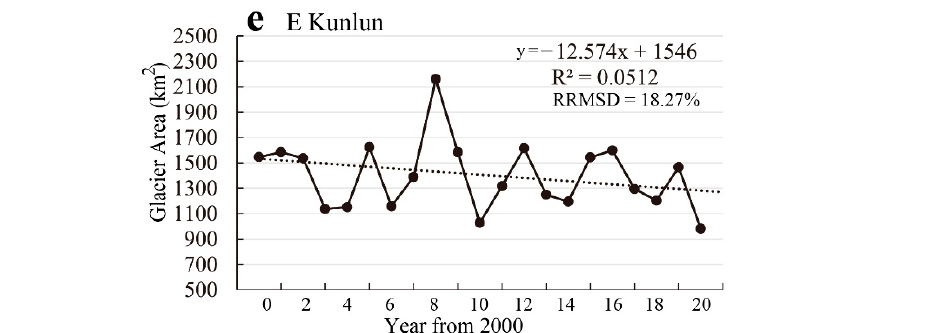
Figure 5. Evolution of annual glacier area in the subregions of the Tarim Basin in 2000–2020: ( a ) E Tien Shan; ( b ) W Tien Shan; ( c ) Pamir; ( d ) W Kunlun; ( e ) E Kunlun. The central map shows the study area and the five subregions with the location of glaciers (light blue color areas).